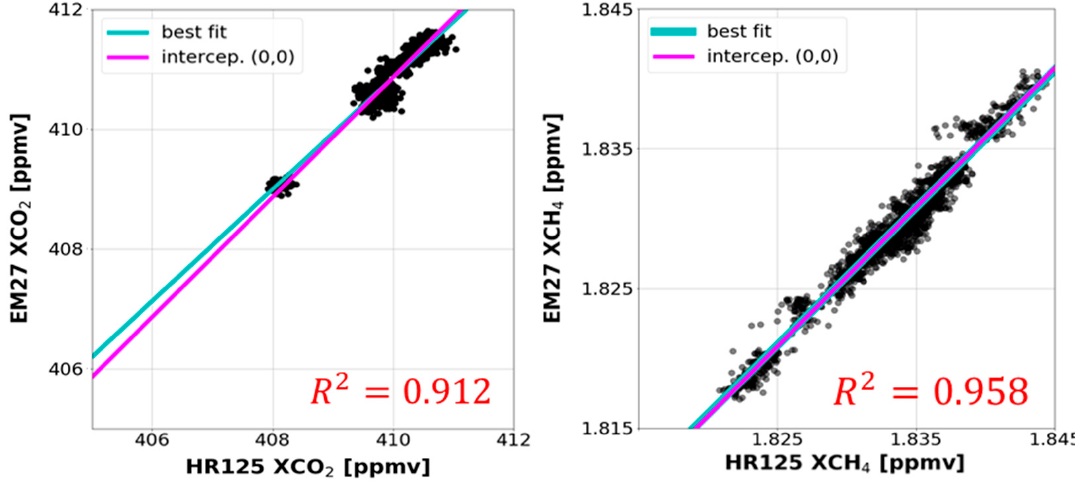
Figure 27. Consistency between XCO 2 and XCH 4 of EM27/SUN and TCCON-HEFEI.